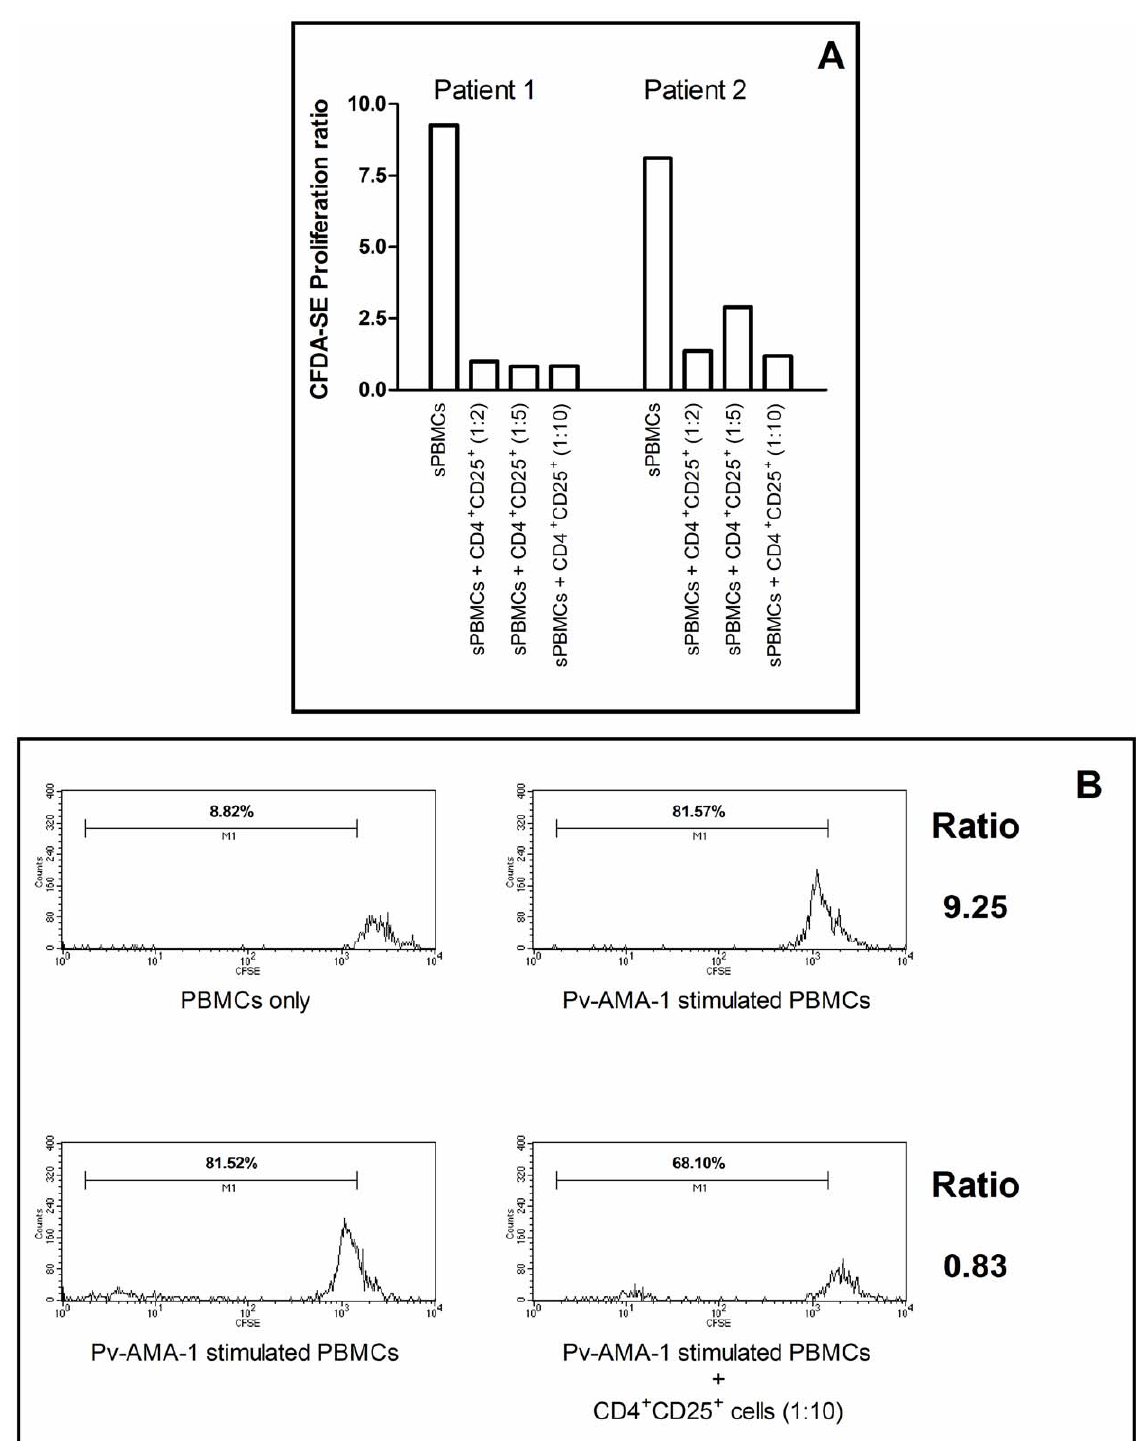
Figure 6. Indirect suppression elicited by CD4 + CD25 + T regulatory cells from P.vivax -infected individuals. (A) CFDA-SE Proliferation ratio of Pv-AMA-1- stimulated PBMCs (sPBMCs) and sPBMCs co-cultured with different proportions of autologous CD4 + CD25 + lymphocytes (1:2, 1:5 and 1:10, CD4 + CD25 + cells: sPBMCs). Results are expressed for two malaria-infected donors who presented positive proliferative response after Pv- AMA-1 stimulation. (B) Representative FACS histogram plots for 1 out 2 donors with positive proliferative response after Pv-AMA-1 stimulation showing CFDA-SE staining after antigen stimulation and co-culturing with CD4 + CD25 + T cells. CFDA-SE Proliferation ratio for sPBMCs was calculated by proliferative response observed in Pv-AMA-1-stimulated PBMCs (indicated by positivity for CFDA-SE) divided by basal proliferative response of non-stimulated cells (PBMCs only). CFDA-SE Proliferation ratio for co-cultured cells were calculated by proliferative response observed in Pv-AMA-1- stimulated PBMCs with CD4 + CD25 + T cells divided by proliferative response observed in Pv-AMA-1-stimulated PBMCs only.